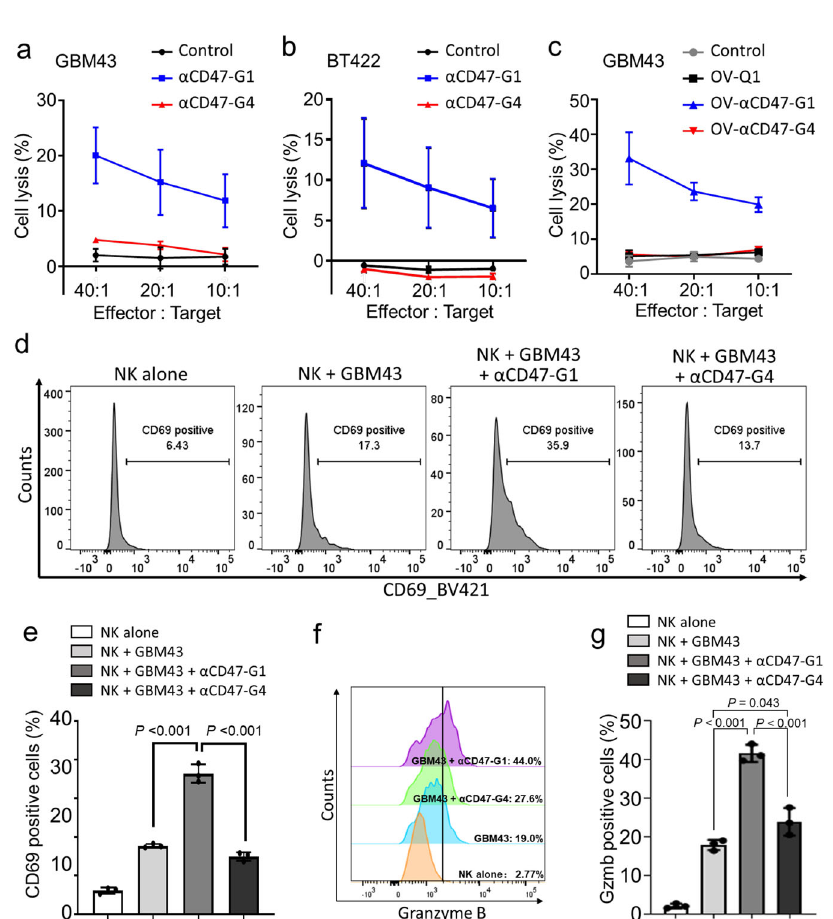
Fig. 3 α CD47-G1 but not α CD47-G4 induces cytotoxicity of human NK cells against GBM cells. a , b Cytotoxicity of human primary NK cells against α CD47-G1- and α CD47-G4-treated ( a ) GBM43 and ( b ) BT422 human GBM cells. c Cytotoxicity of human primary NK cells against GBM43 cells in control media or conditioned media from the culture of OV-Q1-, OV- α CD47-G1- or OV- α CD47-G4-infected U251T2 GBM cells. d The effect of α CD47-G1 or α CD47-G4 on the expression of the NK cell activation marker CD69 when cocultured with GBM43 cells at an effector:target ratio of 1:1. e Summary data of ( d ). All experiments were performed with three donors in triplicate. f The effect of α CD47-G1 and α CD47-G4 on granzyme B expression of NK cells when cocultured with GBM43 cells. g Summary data of ( f ). All experiments were performed with three donors in triplicate. Error bars represent standard deviations of means of three donors. For ( e ) and ( g ), one-way ANOVA with P values corrected for multiple comparisons by the Bonferroni